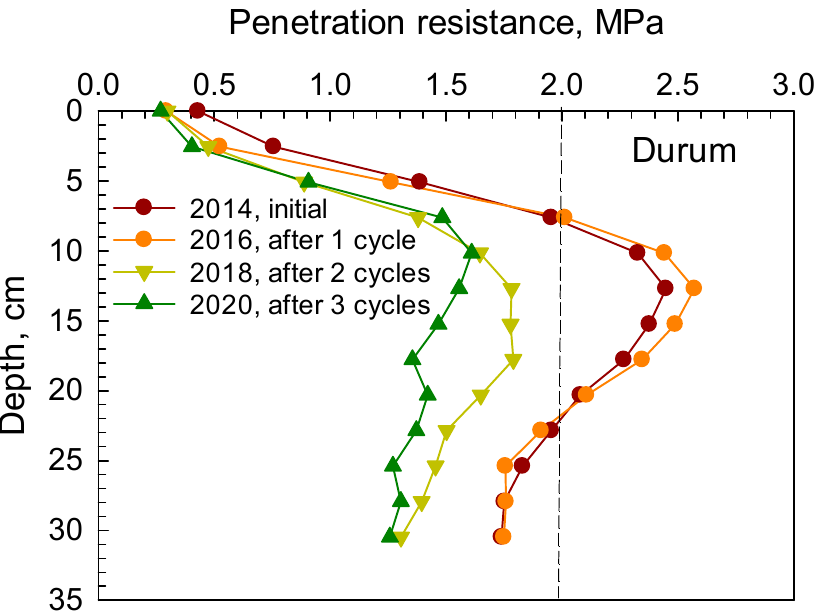
Figure 4. Initial mean soil penetration resistance across all plots in 2014 and after 1 cycle in 2016, after 2 cycles in 2018, and after 3 cycles in 2020 for cover crop mix as a previous crop.